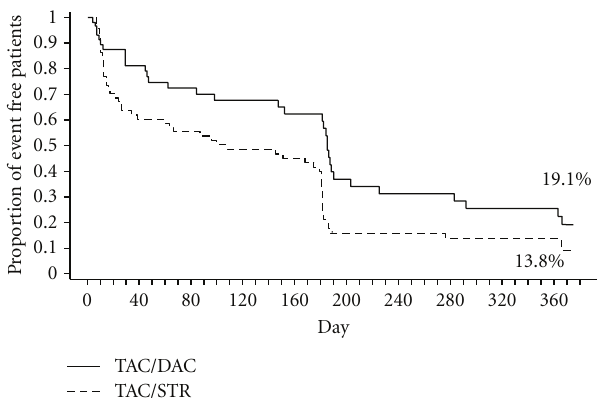
Figure 2: Estimated rate of patients free from recurrence of HCV Infection (Kaplan-Meier Method) at 12 months as confirmed by central biopsy. Freedom from HCV recurrence at 12 months was 19.1% with the TAC/DAC steroid-free protocol and 13.8% with the TAC/STR protocol (Kaplan-Meier method) with a significant di ff erence in survival curves between treatments (95% CI, − 0.105 to 0.211%; P = 0 . 020, Wilcoxon Gehan test). Protocol biopsies were performed at months 6 and 12 accounting for the higher number of events reported at these time points. TAC: tacrolimus; DAC: daclizumab; STR: